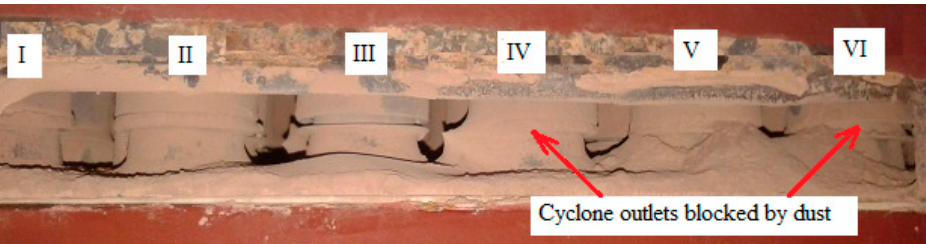
Figure 16. The cyclone outlets of the multi-cyclone after a supply of 500 g of dust into the multicyclone.